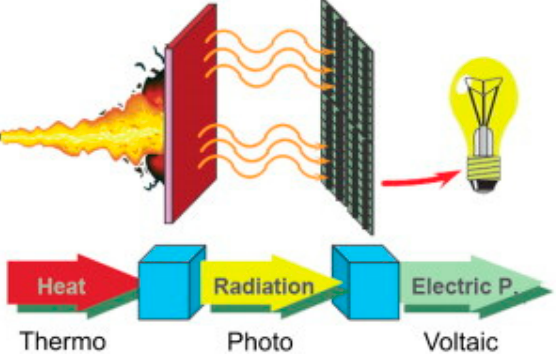
Figure 1. A flowchart of the working of the thermophotovoltaic module.